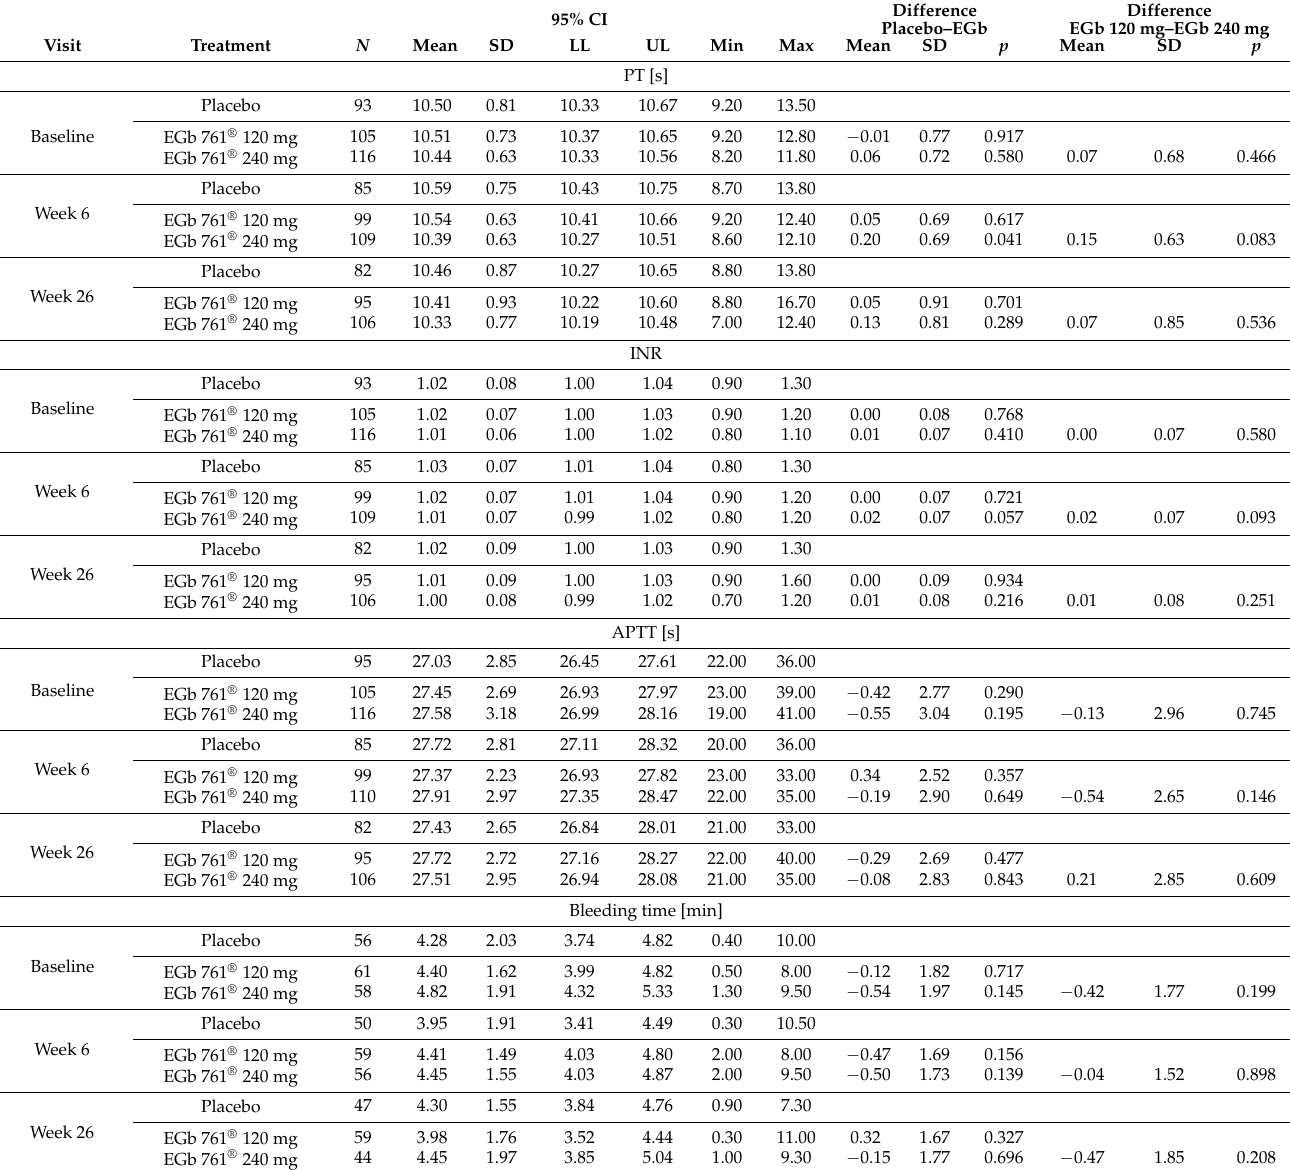
Table 2. Coagulation parameters and bleeding time of patients taking neither acetylsalicylic acid nor warfarin.